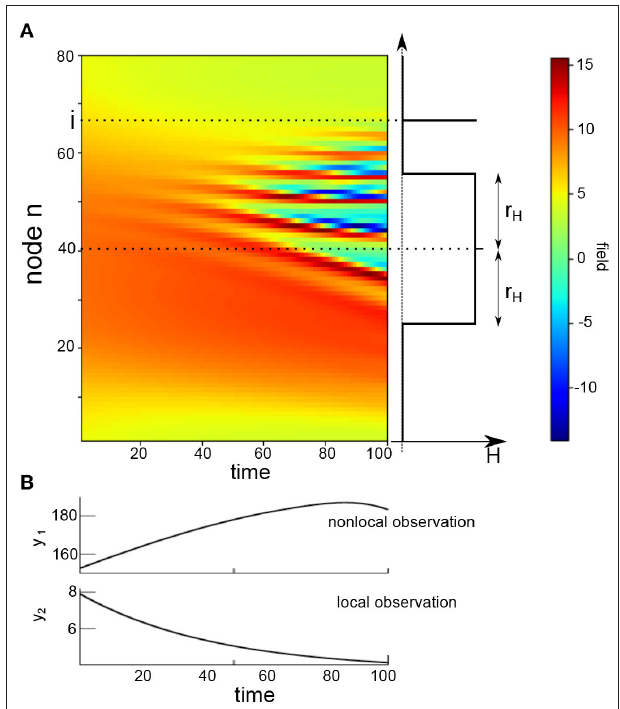
FIGURE 2 | The model field V from Equation (1) and an illustration of the observation operator H from Equation (12) with the sensitivity function width r H . (A) Exemplary space-time distribution of the model solution (left hand side) with the parameters I 8.0 and N 80, the sketched position i of a local = = observation and a sketched sensitivity function of nonlocal observation with the center in the middle of the spatial field with radius r H . (B) Example observations illustrating that local and nonlocal observations are scalars and may evolve differently over time. Please also note the different order of values of the two observation